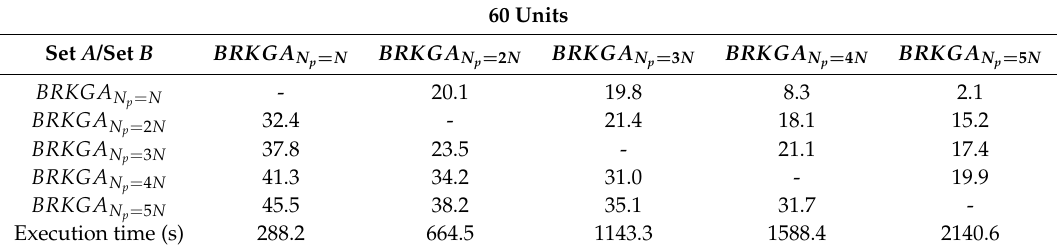
Table 3. Percentage of Non-dominated Solutions of set B covered by those in set A for case study 1 with pc = 0.7.